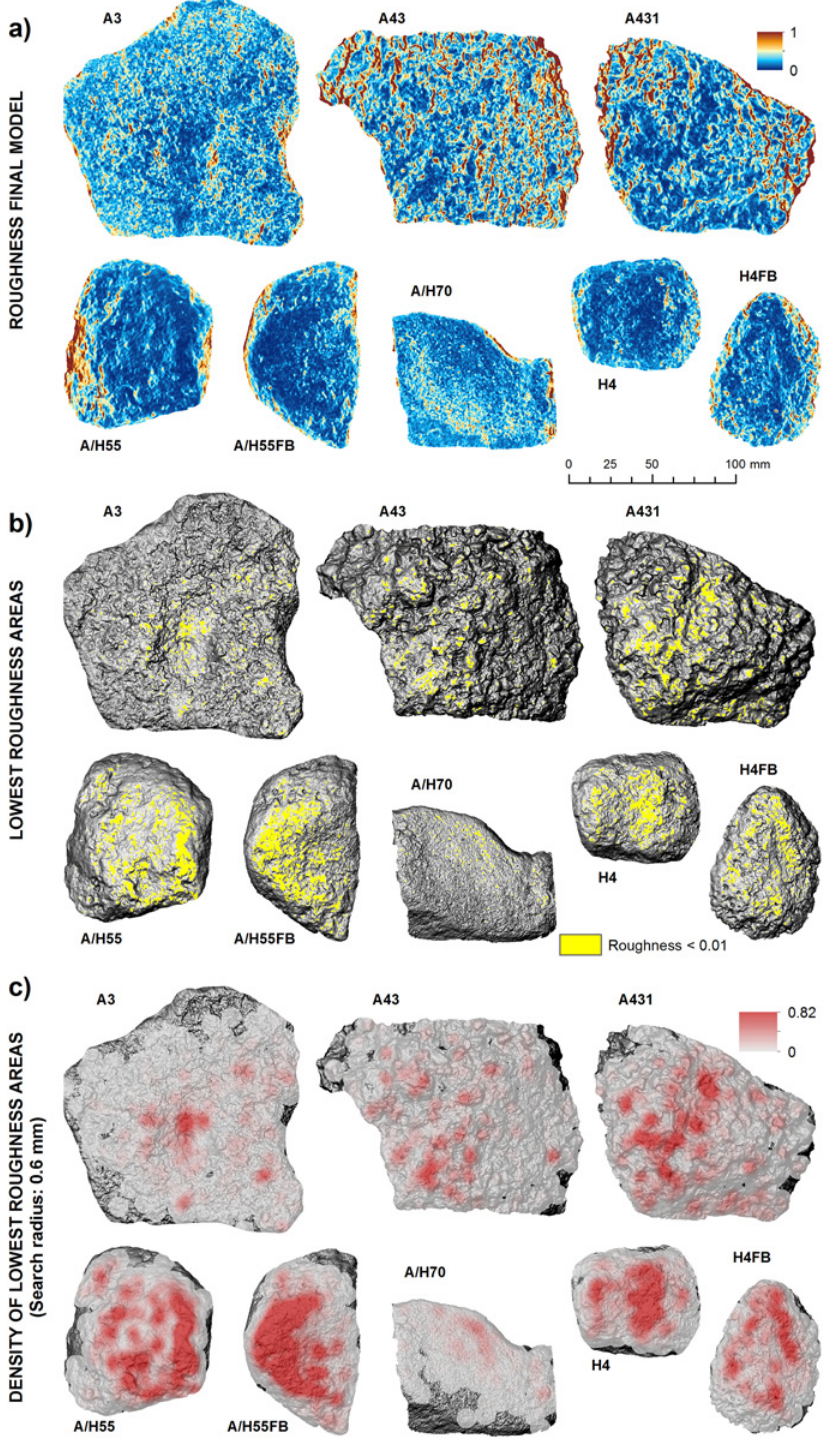
Fig 3. Roughness model applied to the identification of polished areas. A). Roughness final model derived from the combination of roughness models TRI, VRM and 3D/2D area ratio. Lowest roughness areas (values < 0.01) identified in the roughness final model. Density map of lowest roughness areas, computed using a search radius of 0.6 mm.